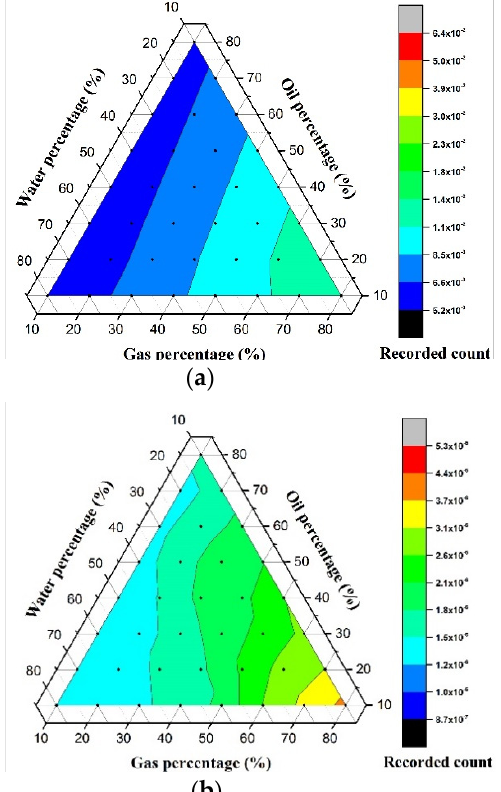
Figure 3. Recorded counts under Photopeaks of ( a ) 241 Am and ( b ) 133 Ba radioisotope in the second detector for different combined oil, gas and water volume fractions at thickness scale of 1.5 cm.